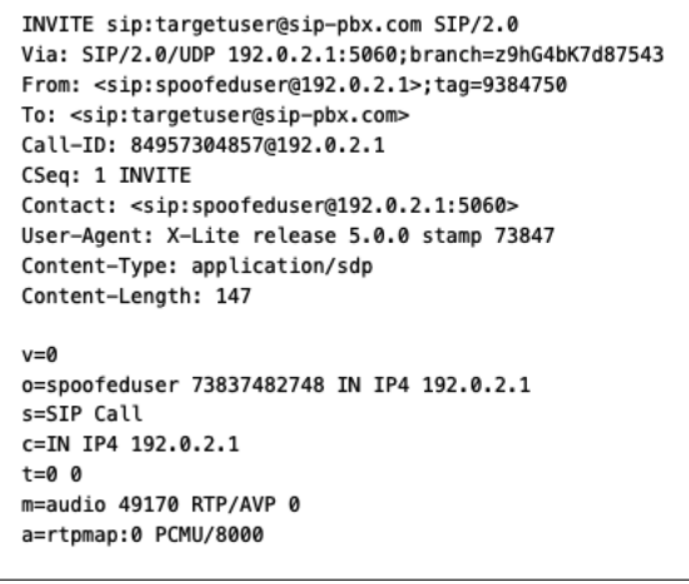
Figure 2. SIP DRDoS INVITE message